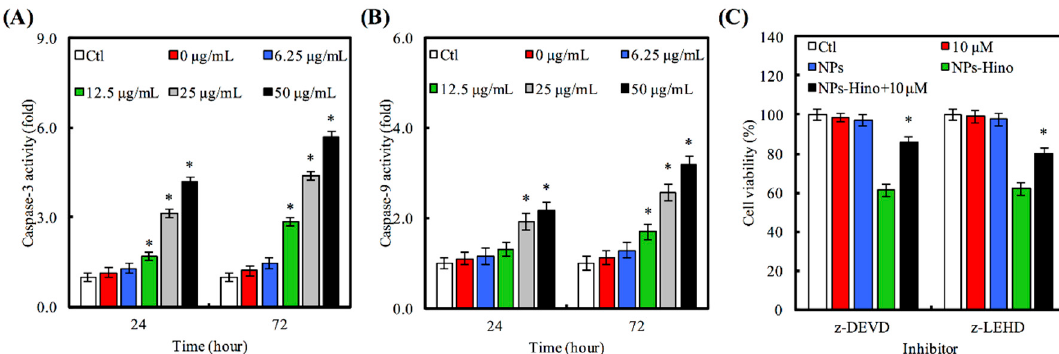
Figure 6. Effects of ( A ) caspase-3 and ( B ) caspase-9 activity on Hino-MCS nanoparticles-treated A549 cells. Star indicates a significant difference ( p < 0.05) compared to 0 μ g/mL; ( C ) Before A549 cells were exposed to Hino-MCS nanoparticles, they were pretreated with or without 10 µ M of caspase-9 (z-LEHD) and caspase-3 inhibitor (z-DEVD), respectively. Star indicates a significant difference ( p < 0.05) compared to cell without pretreatment inhibitor.